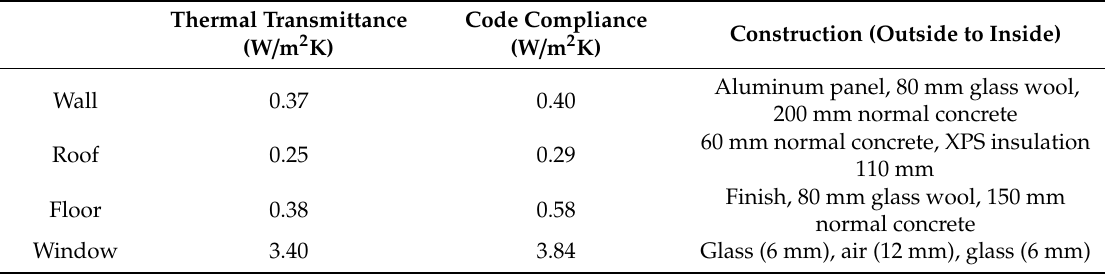
Table 1. Thermophysical properties of the case study